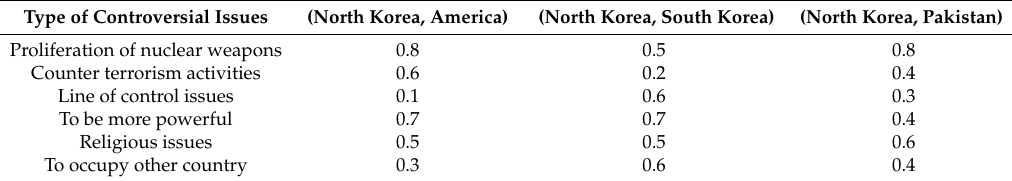
Table 4. Fuzzy set of controversial issues between North Korea and other countries.